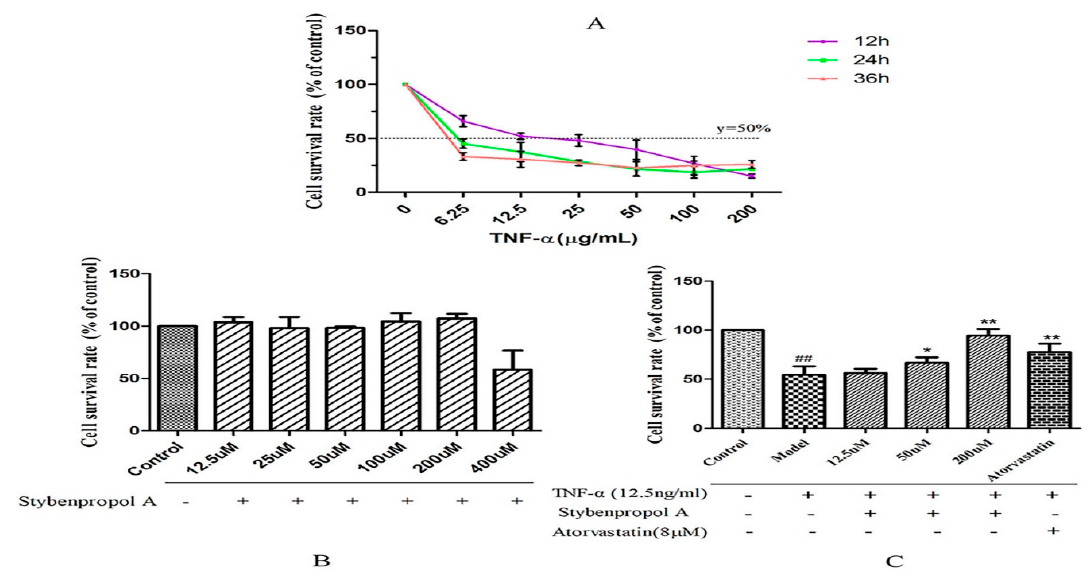
Figure 3. E ff ects of stybenpropol A on tumor necrosis factor- α (TNF- α )-mediated HUVECs. ( A ) TNF- α (6.25–200 µ g / mL) was used to treat HUVECs for the indicated times (12, 24, and 36 h). A CCK-8 assay was then used to measure viability. ( B ) Stybenpropol A treatment did not decrease HUVEC viability. ( C ) HUVECs were pretreated using stybenpropol A (12.5, 50, and 200 µ mol / L) or atorvastatin (8 µ mol / L) for 24 h, after which TNF- α was added for 12 h and viability was assessed. Data are means ± SD of three independent experiments. ## p < 0.01 vs. control; ∗ p < 0.05, ∗∗ p < 0.01 vs. model group.